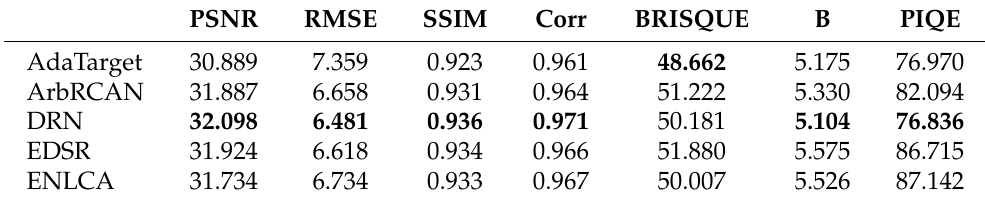
Figure 16. Local manifestation of the super-resolution results on the FY4ASRcolor dataset: Patch 4. Table 1. Evaluation on FY4ASRgray with Pre-trained Parameters.